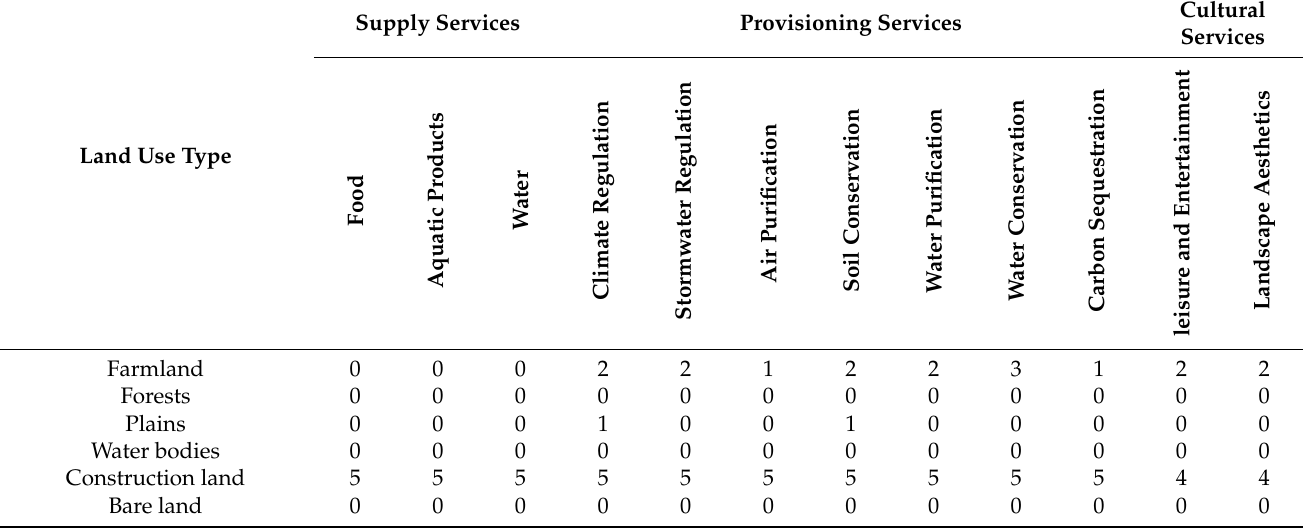
Table 2. Huai River Basin ecosystem services demand